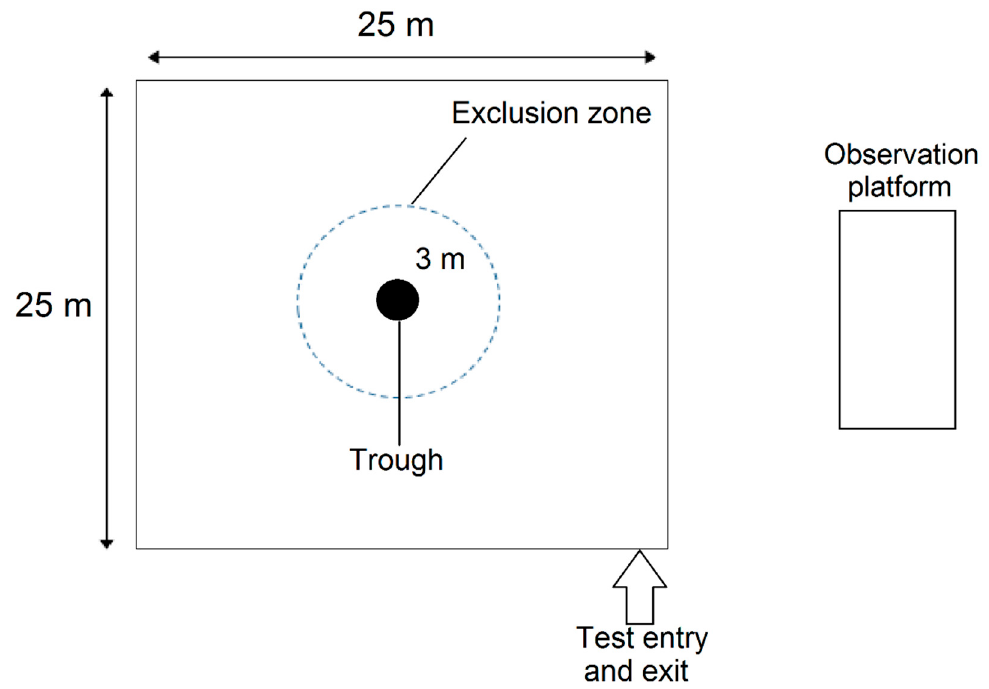
Figure 1. Schematic of the test paddock used for experiment 1 and 2, the area was approximately 25 × 25 m, with the trough placed in the centre. An exclusion zone three m around the trough was discreetly marked with rocks.